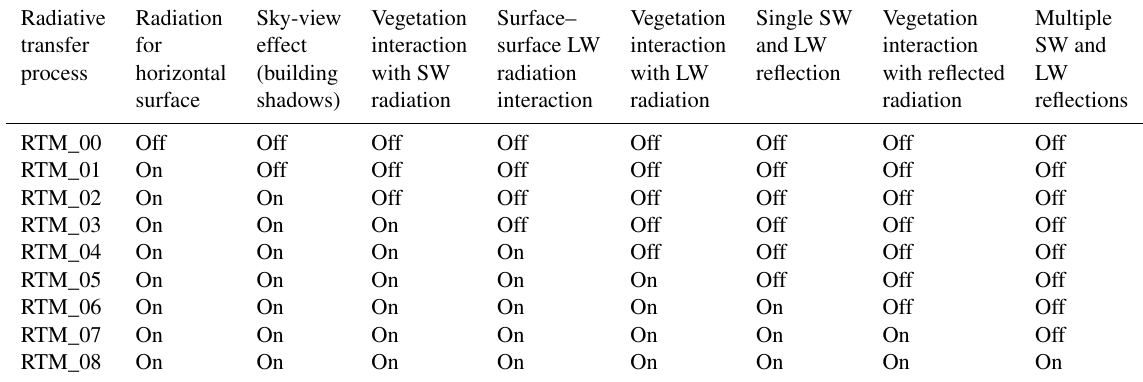
Table 1. Composition of radiative transfer processes (RTPs) for each radiative transfer model (RTM) used in the stepwise parameterization method